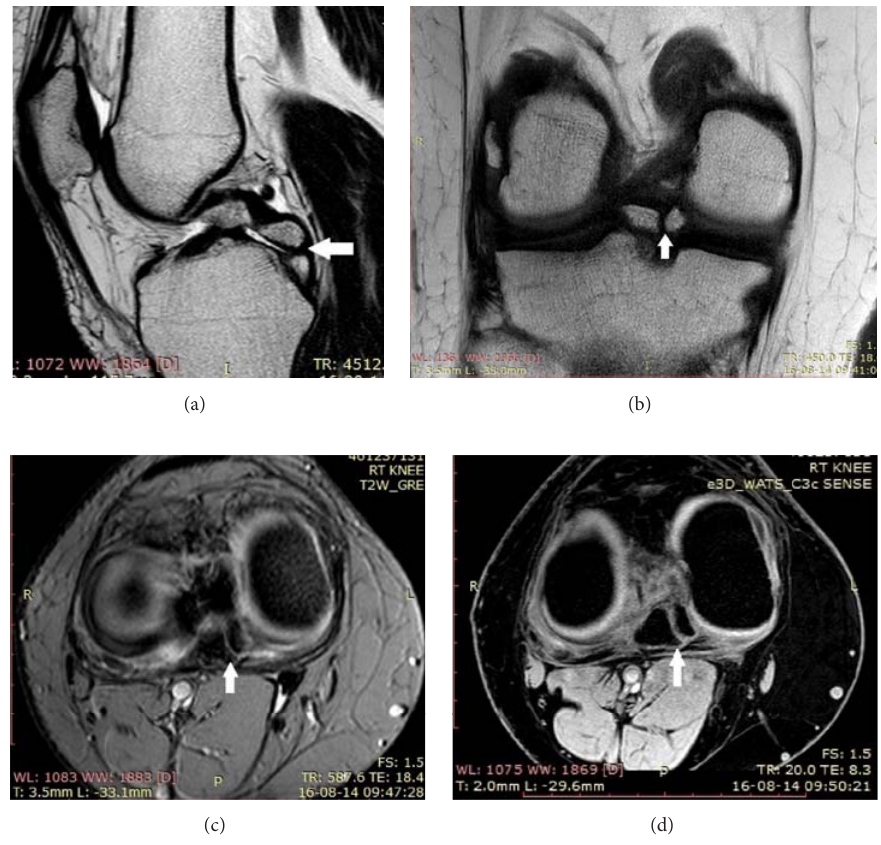
Figure 1: A 21-year young male student presented with chronic pain in the right knee joint for 1-2 years subsequently diagnosed as double meniscal ossicle of the knee. (a) Sagittal T1W image shows two small lesions (solid arrow), isointense to bone marrow in relation to the posterior horn of the medial meniscus, with a hypointense rim. (b) Coronal T1 W images confirm the isointensity of the lesions (solid arrow) to the bone marrow in relation to posterior aspect of medial meniscus. (c) Axial high-resolution T2 GRE image confirms the relationship of the meniscal ossicle (solid arrow) with the posterior horn of the medial meniscus. (d) Axial high-resolution T2 DESS image confirms the relationship of the meniscal ossicle (solid arrow) with the posterior horn of the medial